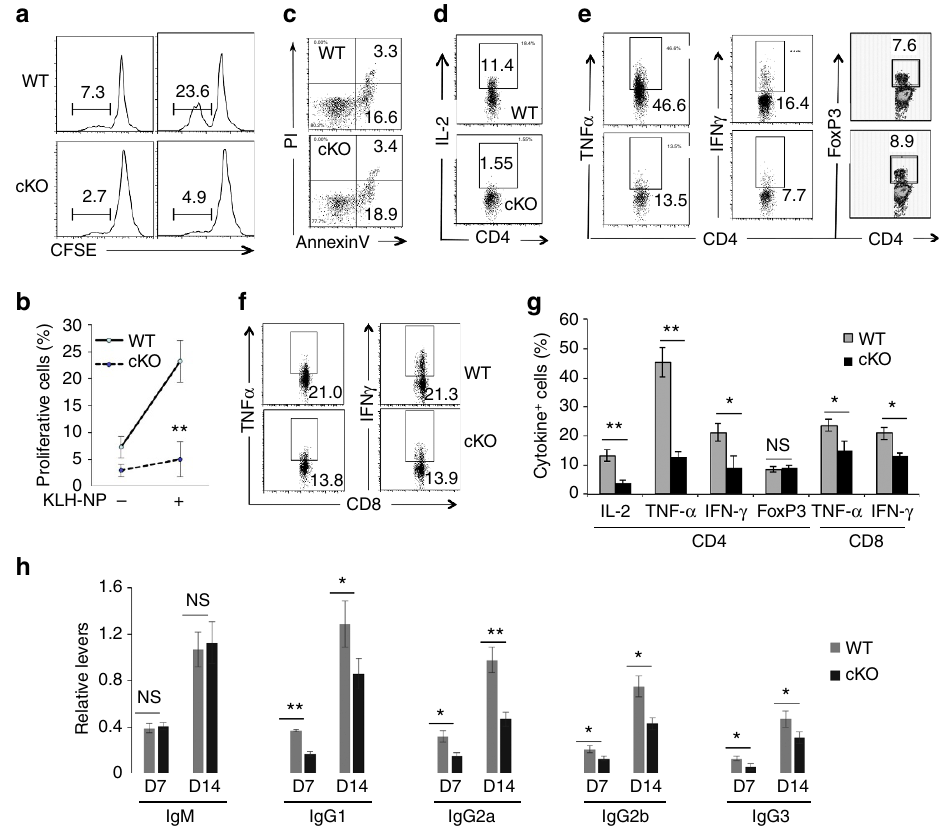
Figure 2 | Impaired antigen-specific T-cell immune response in Hrd1 cKO mice. WT and Hrd1 cKO mice were immunized with 50 m g KLH-NP in CFA on day 1 followed by a boosted immunization with 50 m g KLH-NP in IFA on day 8. Mice were killed on day 14. ( a – c ) Total splenocytes were stained with CFSE and cultivated with 100ngml (cid:2) 1 of KLH-NP for 5 days. The proliferation ( a , b ) and apoptosis ( c ) of CD4 þ T cells were analysed. The representative images ( a , c ) and data from five pairs of mice ( b ) are shown. ( d – g ) The production of IL-2 in CD4 Tcells ( d ), and TNF- a , IFN- g and FoxP3 þ Tregs in CD4 ( e ) and CD8 ( f ) cells were analysed. The representative data ( d – f ) and the mean ± s.d. ( g ) from five pairs of mice are shown. ( h ) The levels of NP-specific antibodies in the sera of immunized Mann–Whitney test mice were analysed by enzyme-linked immunosorbent assay (ELISA). Error bars represent data from five pairs of mice (mean ± s.d.). The Mann–Whitney test was used for the statistical analysis. NS, no significant difference; * P o 0.05, ** P o 0.01 and *** P o 0.001. destruction. We found that p27 kip1 protein expression (Fig. 3c,d), but not mRNA level (Fig. 3e), was significantly increased in Hrd1